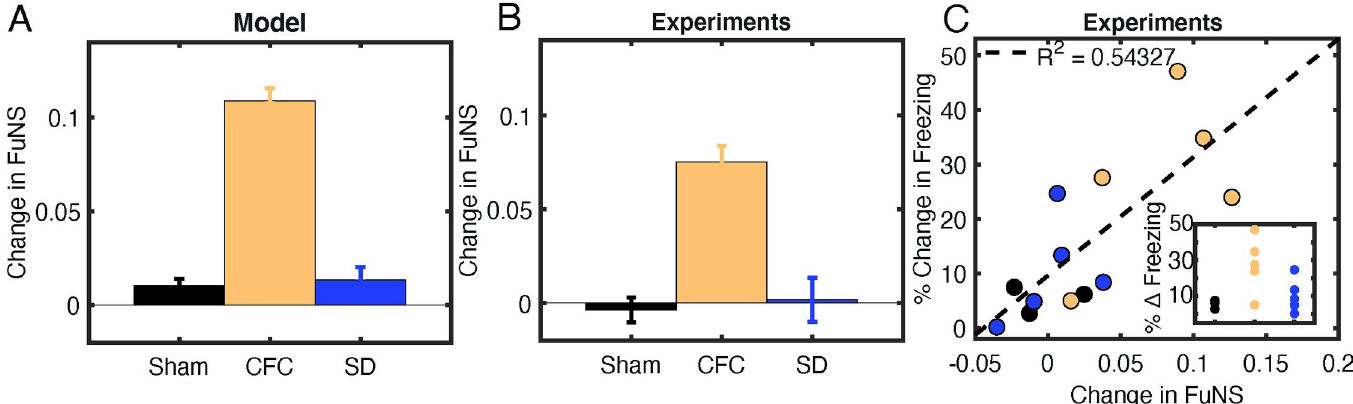
Fig 3. Functional network stability during NREM after initial exposure predicts future level of memory consolidation. A) SIMULATED DATA: Model predictions for the change in FuNS in each simulation group: Sham (NREM states without learning; n = 5) and SD (Wake states with learning; n = 5) show only marginal changes in FuNS whereas CFC (NREM states with learning; n = 5) show a maximal increase in FuNS. All error bars represent the standard error of the mean. B) EXPERIMENTAL DATA: FuNS analysis of CA1 recordings following CFC or Sham conditioning (Sham conditioned—black [n = 3], CFC + SD—blue [n = 5], CFC + sleep–yellow [n = 5]). Ad lib sleep post conditioning leads to the greatest increase in FuNS. C) EXPERIMENTAL DATA: Change in FuNS for each mouse after CFC predicted its memory performance 24 h later (% freezing; raw values shown as inset ). Line indicates best fit to data with R 2 = 0.54.